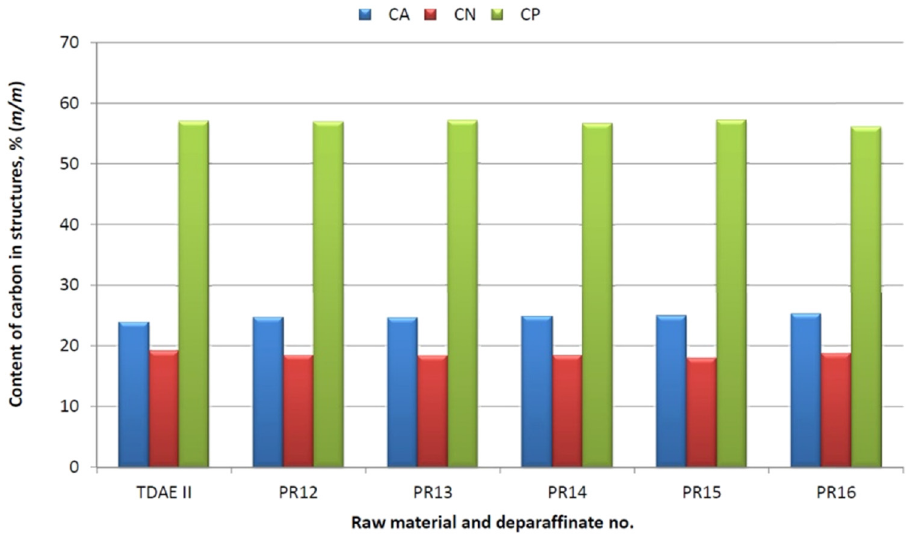
Figure 6: E ff ect of the dewaxing process with the MBIK – MEK solvent on the change of the structural composition of depara ffi nates – TDAE II raw material.